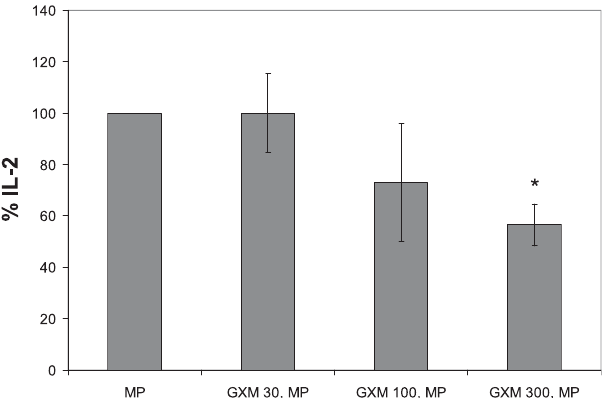
Figure 2. GXM Inhibits the Activation of Cryptococcal MP-Specific T Cells BMDCs were pretreated with varying concentrations of GXM (30, 100, or 300 l g/ml) before the sequential addition of cryptococcal MP and MP- specific hybridoma T cells. Following 24-h incubation, IL-2 levels in the supernatants, a measure of T-cell activation, were measured by bioassay. The data are expressed as percent of IL-2 produced compared with MP alone (set at 100%) and are the average 6 SEM of three to five independent experiments done in triplicate. Mean IL-2 in the MP-alone group was 68 U/ml. * p , 0.001.